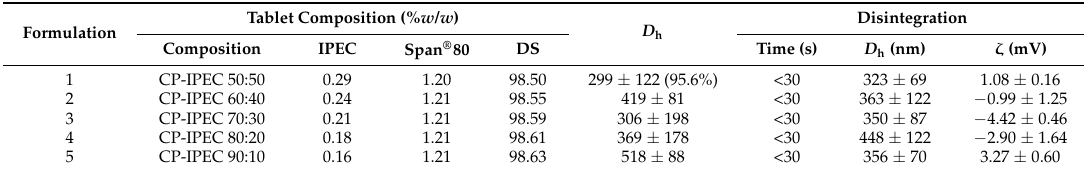
Table 6. Composition of oral lyophilisates containing CP loaded IPECs formed by NAA-1 and EPO in the ratio 33:67 %. The amount of IPEC was defined in order to have 120 µ g drug per unit. The main features of CP loaded IPECs after disintegration were evaluated in terms of particle size ( D h ) and zeta-potential (ζ).